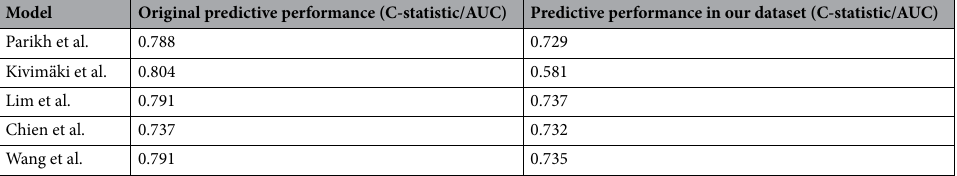
Table 7. The predictive performance of some of the past published hypertension prediction models in our dataset.